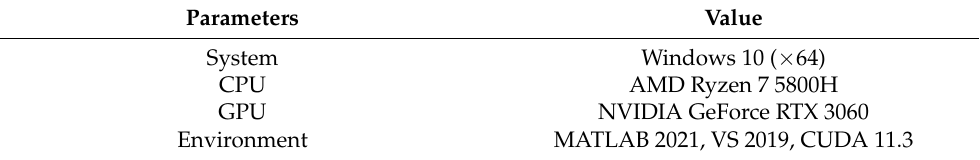
Table 1. Environment specifications.